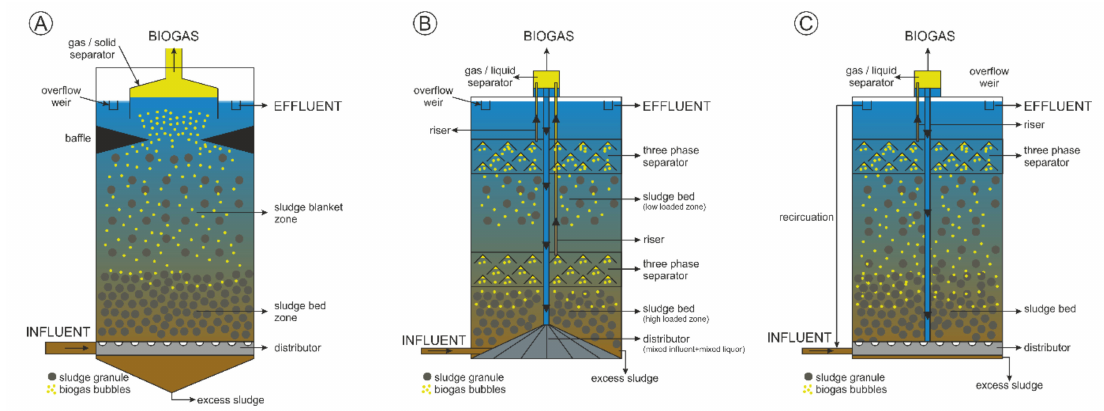
Figure 6. Scheme of an Upflow Anaerobic Sludge Blanket (UASB) reactor ( A ), an Internal Circulation (IC) reactor ( B ) and an Expanded Granular Sludge Blanket (EGSB) reactor ( C